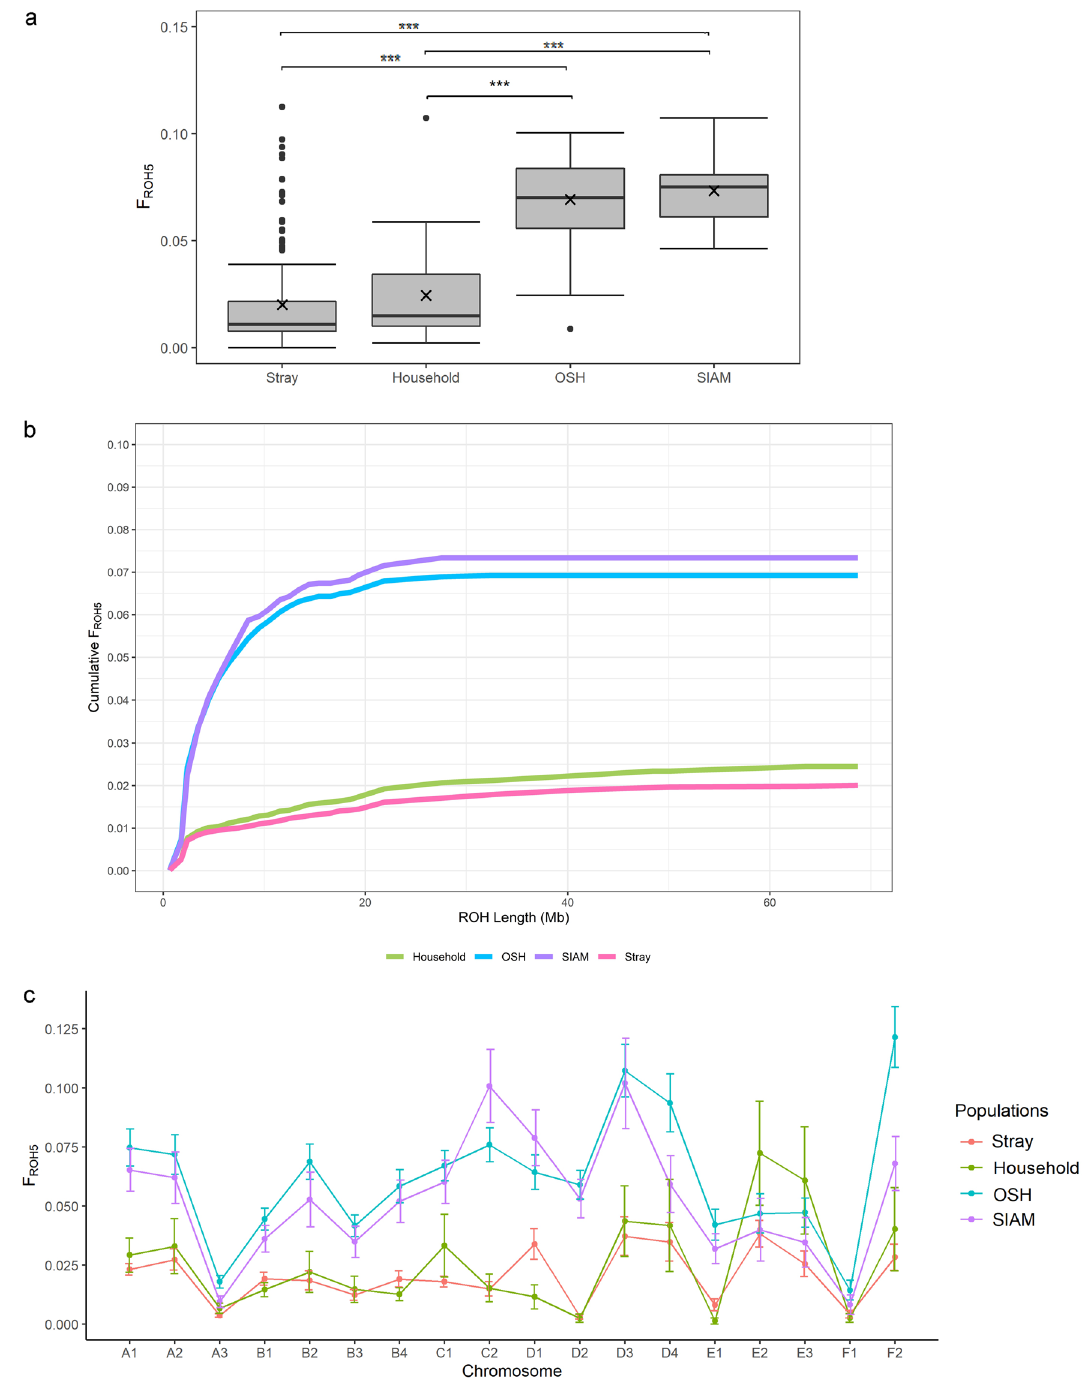
Figure 7. Genomic inbreeding analyses in the four genotyped cat populations. The ROHs detected over ROH5 were analysed. ( a ) Distribution of the genomic inbreeding coefficient FROH5. Outliers are shown as dots. Median and mean values are indicated with a thick horizontal line and a cross. ***p < 0.0001 ( b ) Cumulative genomic inbreeding coefficients for stray, household, OSH and SIAM by ROH lengths in windows of Mb. ( c ) Average genomic inbreeding for the 18 autosomes by stray, household, OSH and